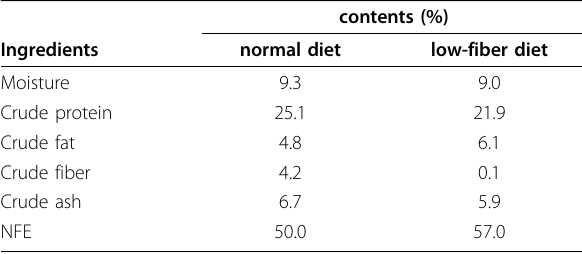
days significantly increased the frequency and wet The effect of low-fiber diet on stool parameters weight of stools to 20.8 ± 2.98 and 6.00 ± 1.10 g, respec- Before assessing the laxative effects of EEA and senna tively, at 300 mg/kg or to 25.5 ± 5.42 and 8.09 ± 1.91 g, on low-fiber diet-induced constipation in rats, the effects respectively, at 600 mg/kg (Figure 2B and 2D). A single of a 5 week treatment with a low-fiber diet were deter- administration of EEA at 150 mg/kg showed a tendency mined on the frequency, weight, and water content of stools. Rats were purchased at 6 weeks old and main- tained on a normal diet (as a control) or on a low-fiber Table 1 Composition of the normal diet and low-fiber diet for 5 weeks. After 5 weeks of feeding, carmine (10 diet mg/body) was orally administered, then stool frequency, contents (%) weight, and water content were measured (Figure 3A, B, and 3C) and carmine egestion was investigated in each rat during consecutive 2-h periods for 16 h (Table 2). Stool frequency, weight, and water content of rats main-